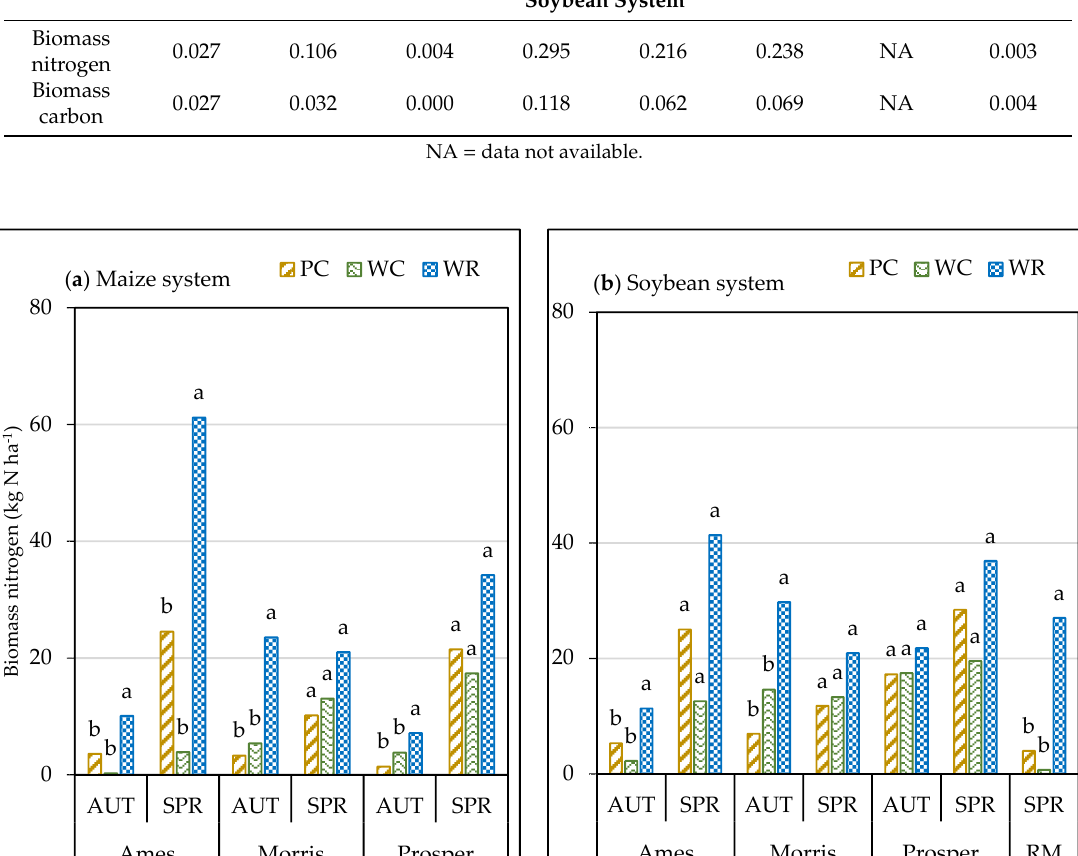
Table 3. Analysis of variance table showing level of significance ( p -values) of cover crop biomass nitrogen and carbon accumulation in autumn and spring at Ames, Morris, Prosper, and Rosemount when cover crops were interseeded in standing maize and soybean.